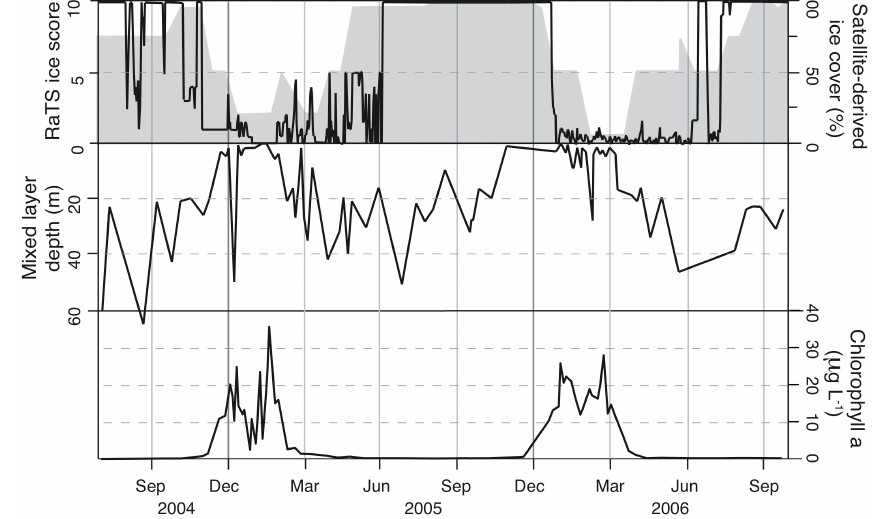
Fig. 2. Time-series plots of sea ice cover (top panel) with the black line representing daily observations in Ryder Bay and the shaded region representing regional sea ice cover of Marguerite Bay (from National Ice Centre – National Oceanic and Atmosphere Administration, Bellingshausen-Amundsen Sea region sea ice cover satellite data, available online: http://www.natice.noaa.gov); mixed layer depth (see text for definition; middle panel); and chlorophyll a concentrations from July 2004 to October 2006 at the RaTS site, water depth 15m (bottom panel). Data courtesy of the British Antarctic Survey, with supplementary data from this